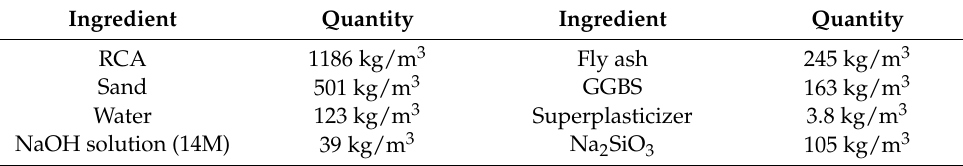
Table 2. Quantities of ingredients of